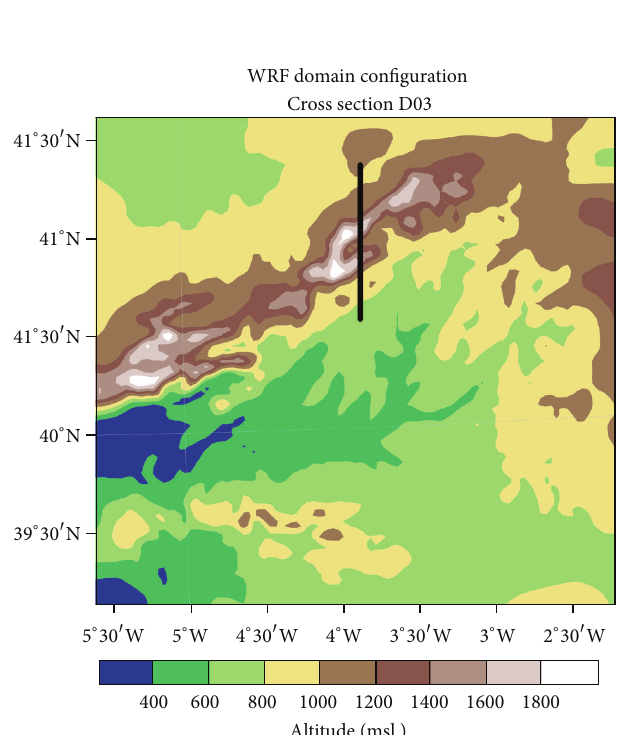
Figure 7: Nested domains used in WRF simulation. Axis from cross section from N to S is overlaid on D02 and D03.